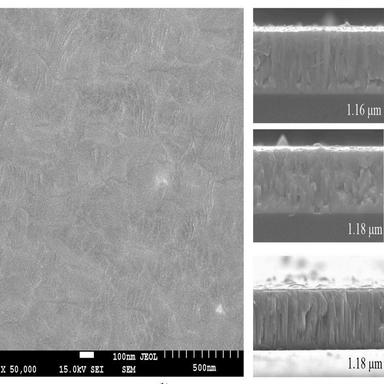
Top-view SEM images and cross-sectional images captured at three regions of each sample: (a) untreated and (b) annealed films; film thickness is specified in the figure.